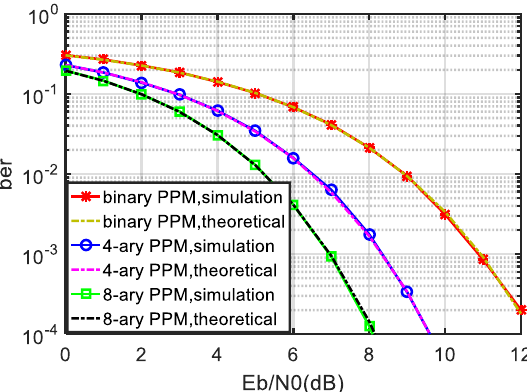
Figure 7. BER performance of noncoherent PPM optimal